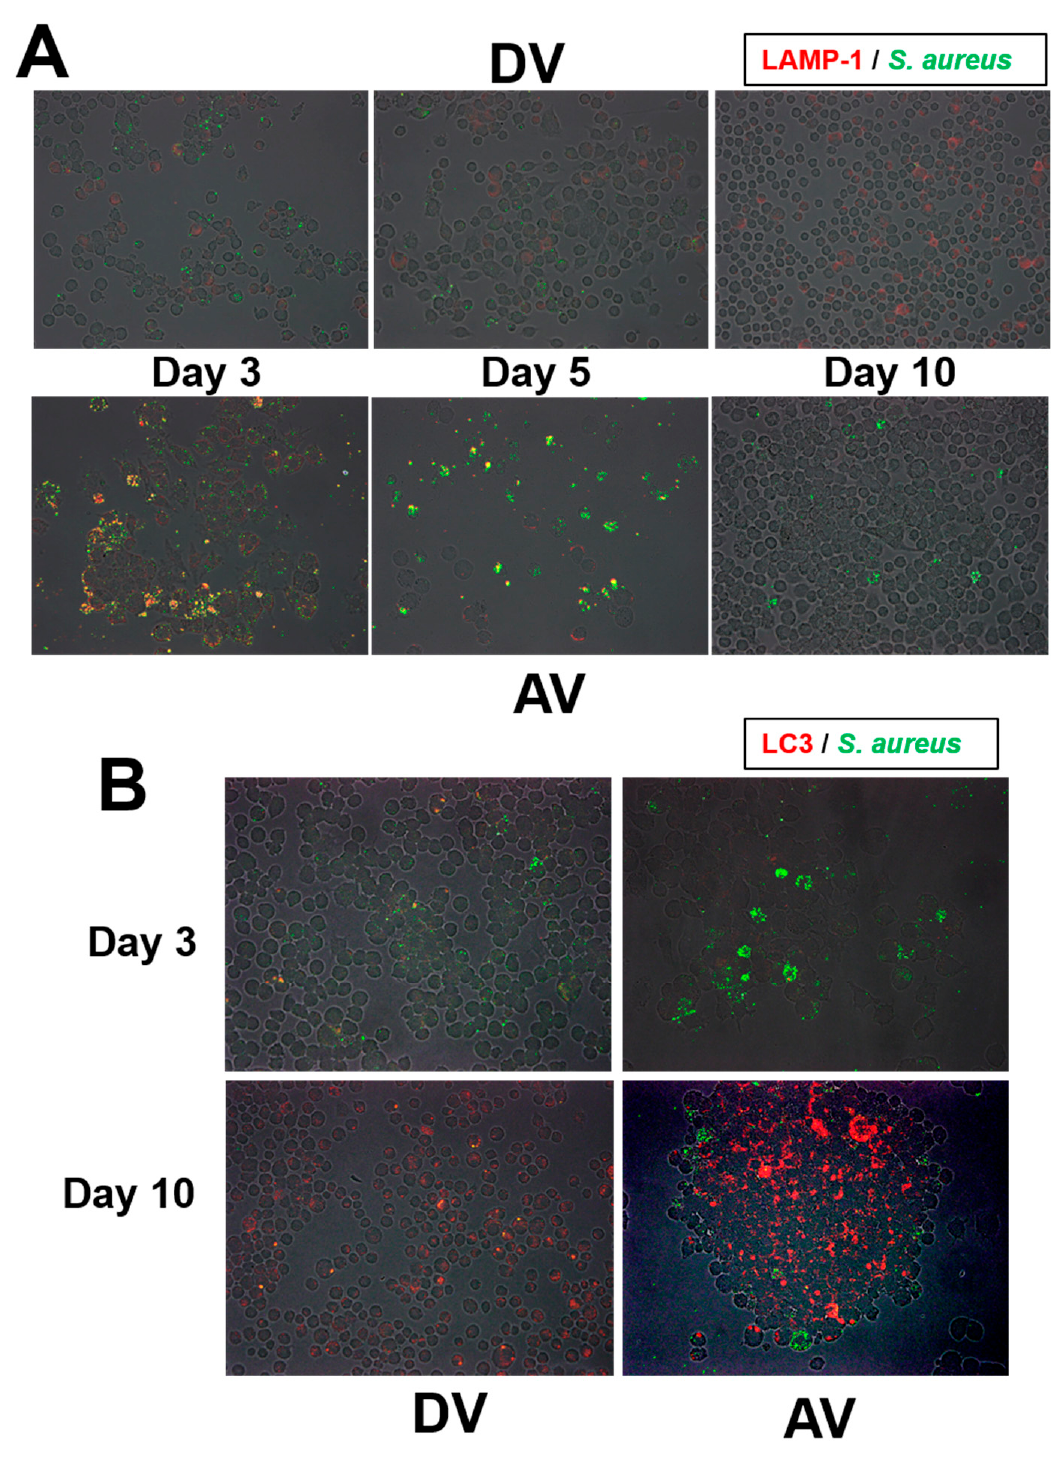
Figure 6. Localization of lysosomes and autophagosomes in J774A after ingesting OJ-1. ( A ) LAMP- 1-positive lysosomes (red) and OJ-1 (green) in J774A at 3, 5, and 10 days after incubation in DV and AV groups. In the AV group, OJ-1 became unassociated with the lysosomes in J774A cells over time. ( B ) LC3-positive autophagosomes (red) and OJ-1 (green) in J774A cells on days 3 and 10. Autophagosomes were progressively formed in J774A cells in group AV on day 10 but were not found in the cells with intracellular OJ-1.